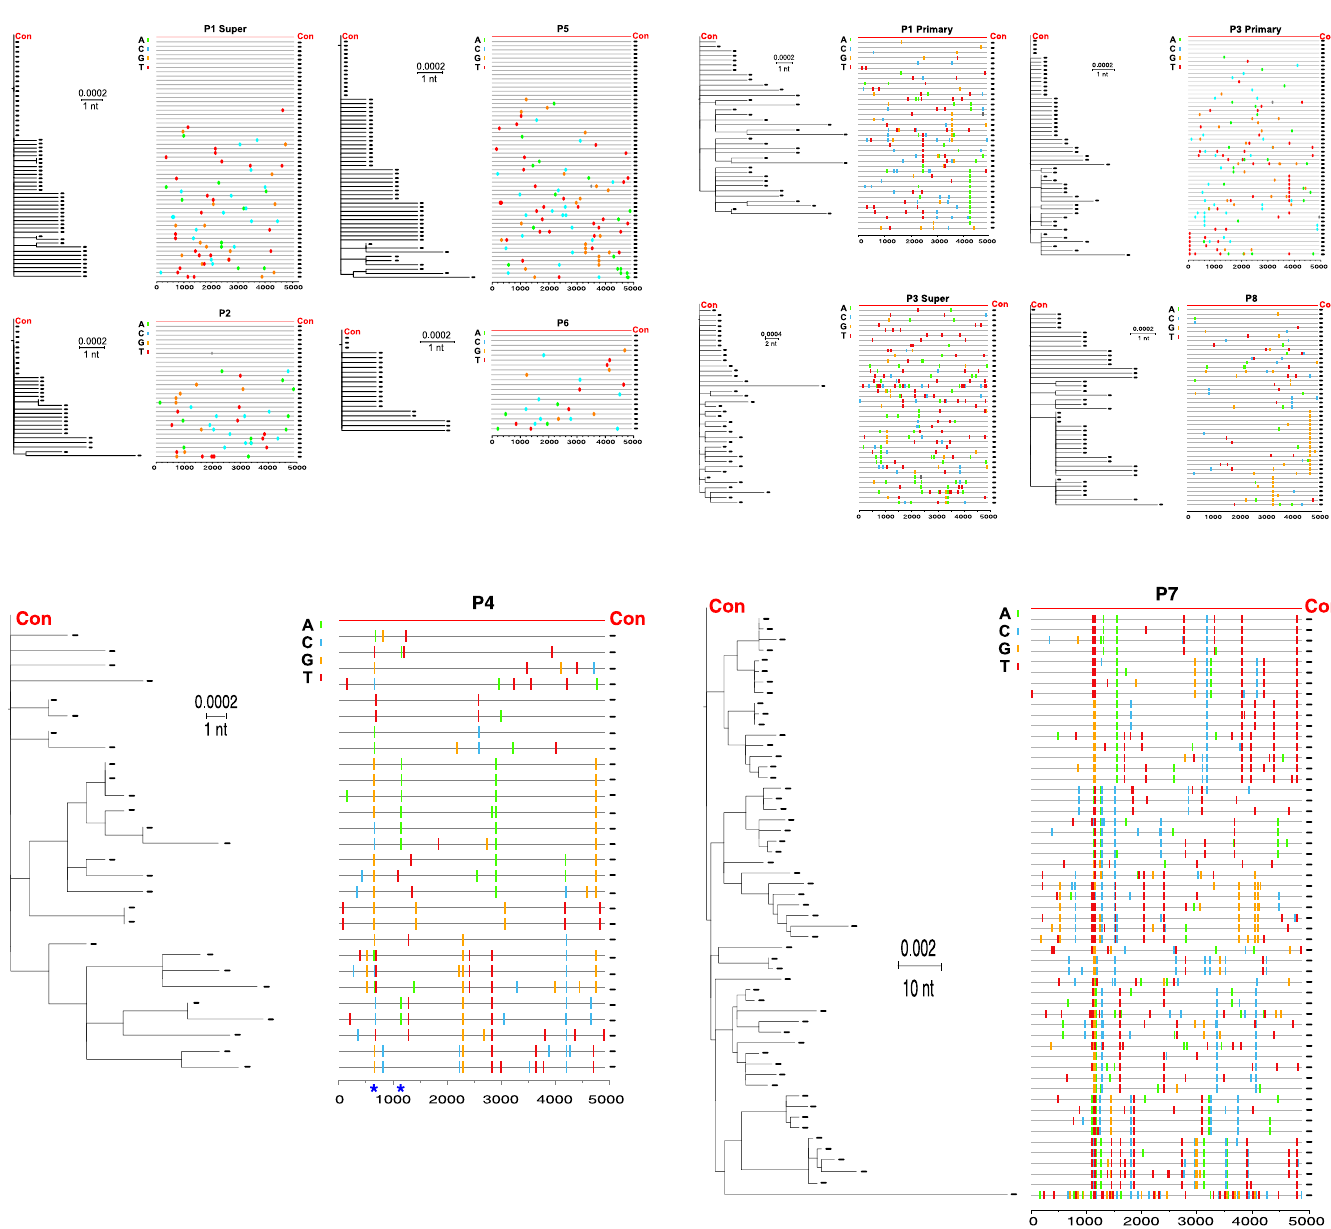
Fig 3. Four patterns of sequence diversity among 10 acute and early hepatitis C virus (HCV) infections in eight HIV-infected men who have sex with men. Maximum-likelihood trees (left) and Highlighter plots of 5’ half genome (core, E1E2, p7, NS2, and NS3) (right) are shown as paired for each infection. For each infection, the consensus sequence (red) was used as the root and the master template in the ML tree and the Highlighter plot, respectively. The sequences in the Highlighter plots are displayed in the same order as the taxa in the Maximum-likelihood trees. A) P1 superinfection, P2, P5, and P6 showed very low sequence diversity and star-like phylogeny, consistent with acquisition of a single founder virus; B) P1 primary infection, P3 primary and superinfections, and P8. These showed very low sequence diversity but had minor deviations from either a Poisson distribution or star-like diversity, but consistent with acquisition of a single founder virus; C) P4 showed very low sequence diversity but had many shared nodes in the phylogenetic tree. The blue stars at nucleotide position 700–708 and 1198–1203 (H77) indicate the amino acid changes at glycosylation site 234 in E1 and residues 400/401 in HVR1 of E2, sites of strong selection. Both nucleotide and amino acid positions were named based on H77 reference sequence. These patterns were most consistent with acquisition of one, or a few (three or four) closely related viruses; and D) P7 showed very high diversity and demonstrated a very complex sequence evolution, most consistent with acquisition of > 10 infecting viruses. P, participant; nt, nucleotide; E1, envelope glycoprotein 1; HVR1, hypervariable region 1; A, adenine; C, cytosine; T, thymine; G, guanine.